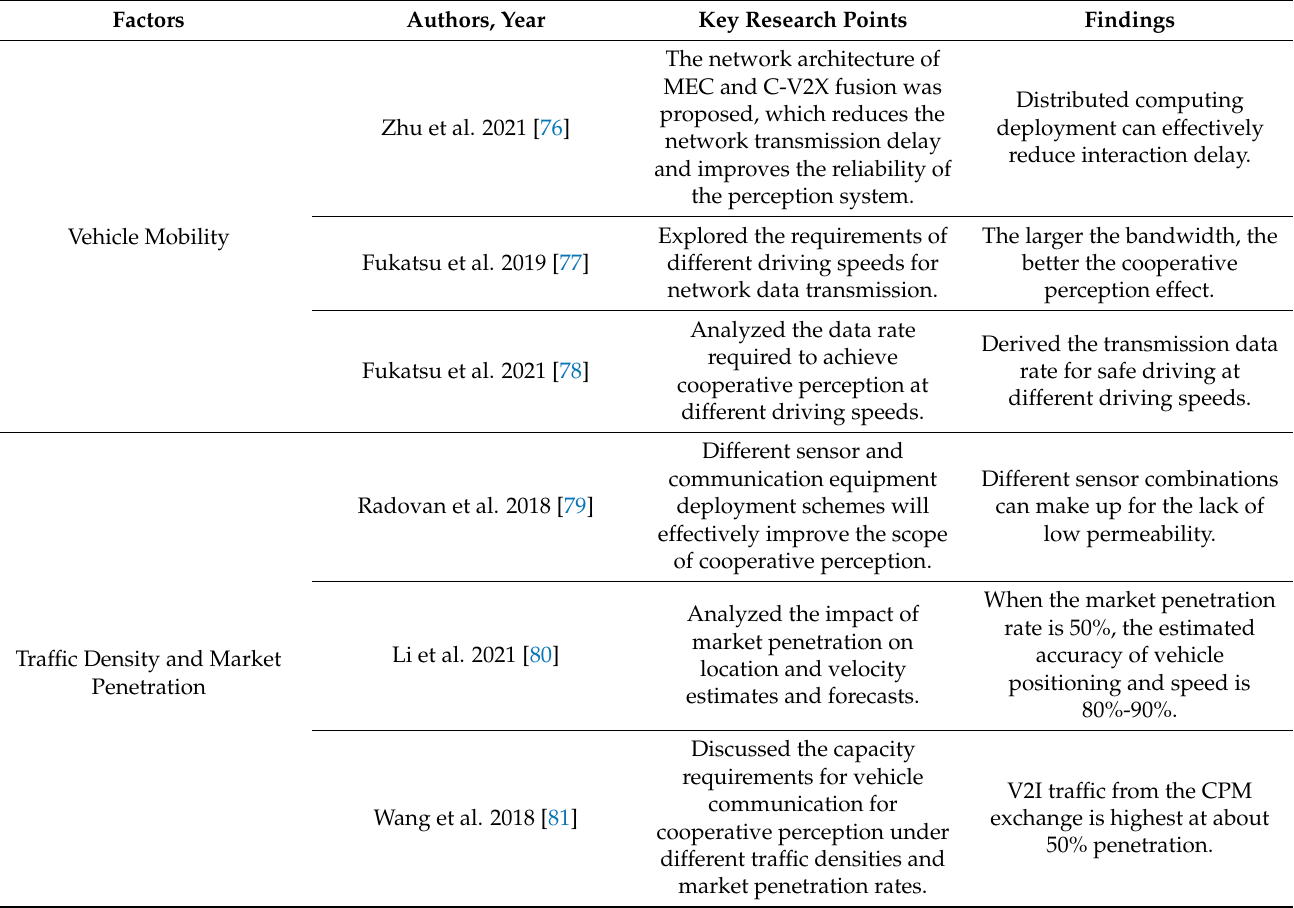
Table 6. Summary of the existing research on cooperative perception information-sharing commu- nication technology according to market penetration rate and vehicle mobility.